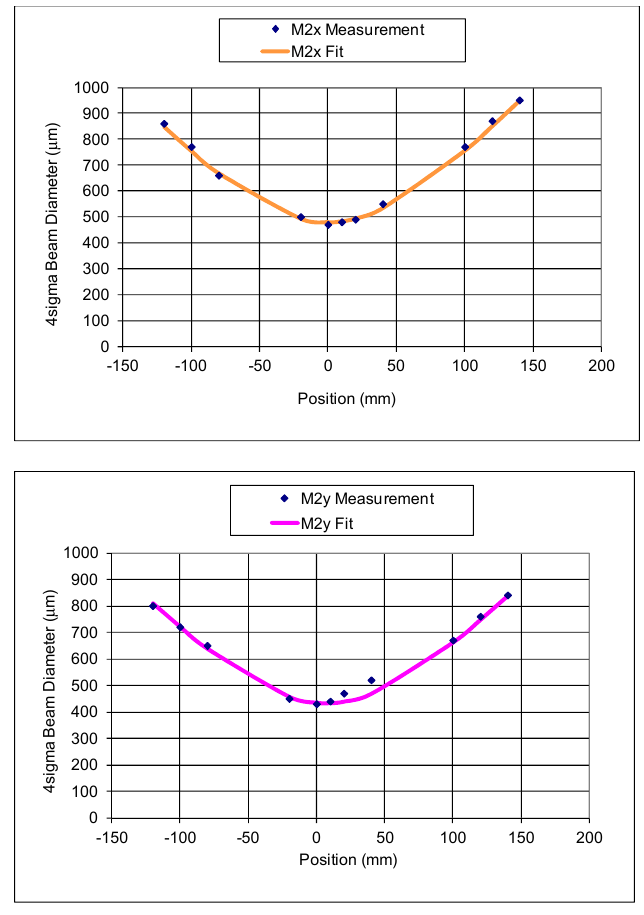
Figure 3. Beam shape and M 2 measurement at 1.3 mJ and 18 kHz with 600 ns pulses.